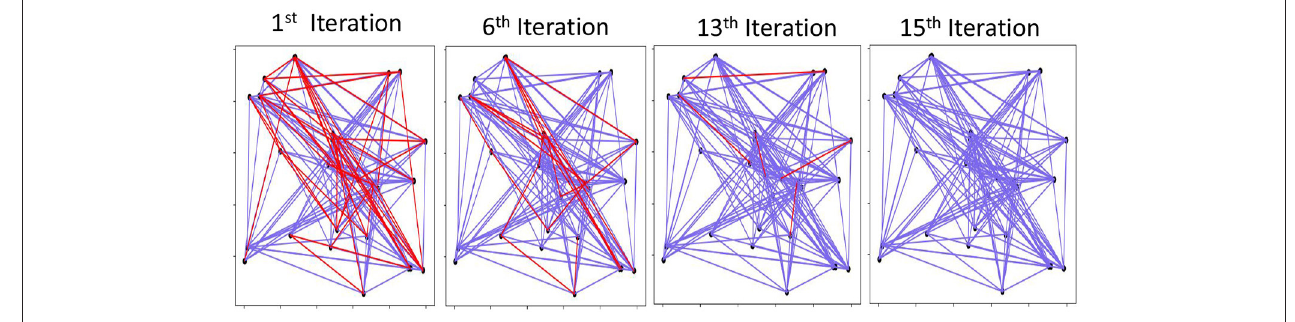
FIGURE 7 | Visual graph reconstruction: red are mismatched edges and blue are existing edges. # Edges